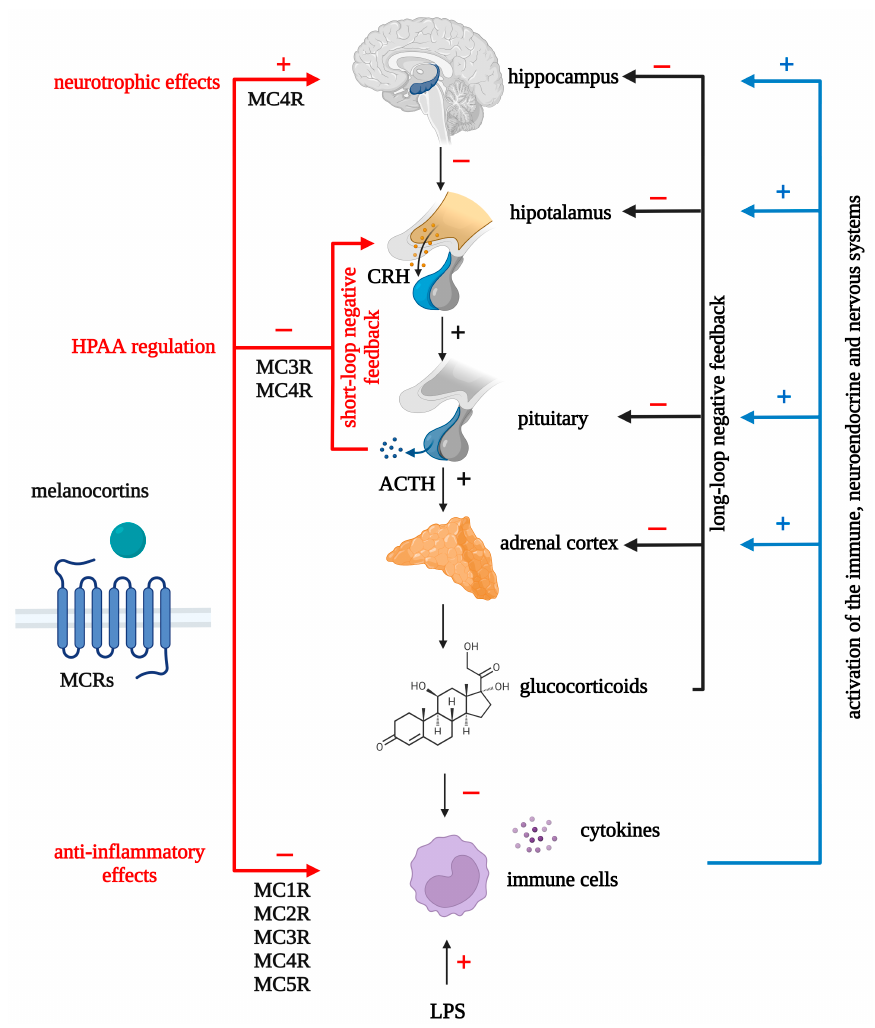
Figure 3. Neurotrophic, neuroendocrine and anti-inflammatory effects of melanocortins. MCRs: melanocortin receptors; MC1R: melanocortin 1 receptor; MC2R: melanocortin 2 receptor; MC3R: melanocortin 3 receptor; MC4R: melanocortin 4 receptor; MC5R: melanocortin 5 receptor; ACTH: adrenocorticotropic hormone; CRH: corticotropin-releasing hormone.